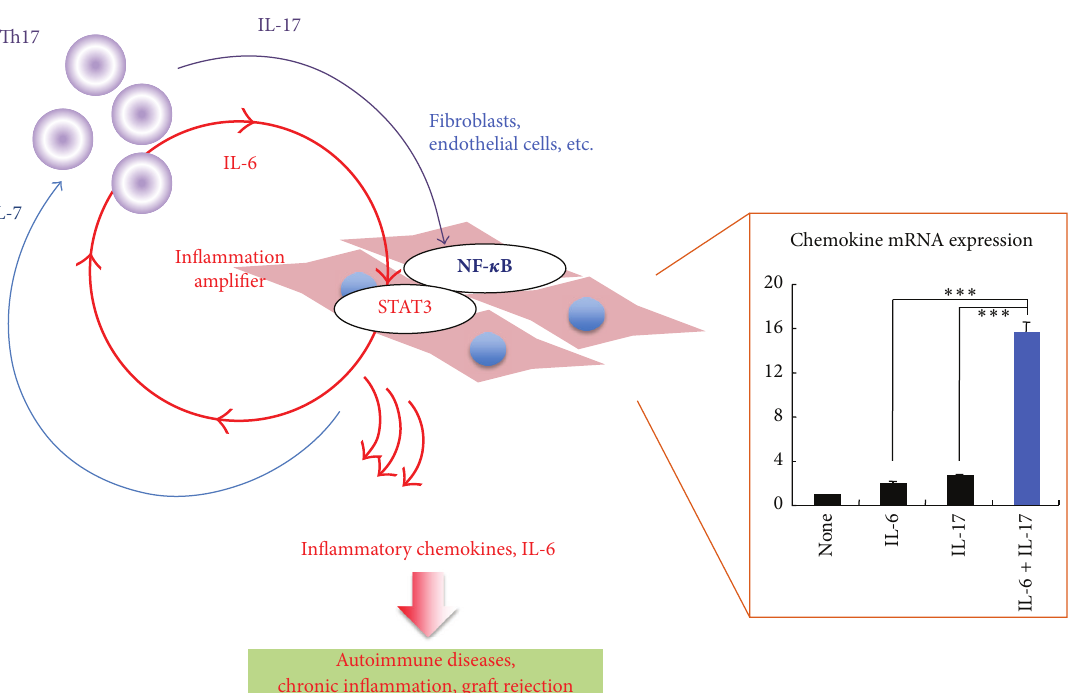
cells and leads to many diseases. This induction is induced by the simultaneous activation of NF- 𝜅 B and STAT3. IL-7 from nonimmune cells alsocontributestoenhancingtheinflammationamplifierbygeneratingTh17cellsand/orsustainingtheirsurvival.Theinflammationamplifier is essential for the pathogenesis of F759 arthritis, EAE, and chronic graft rejection. The bar graph on the right indicates typical expression statuses of chemokines and IL-6 after inflammation amplifier activation (see the blue